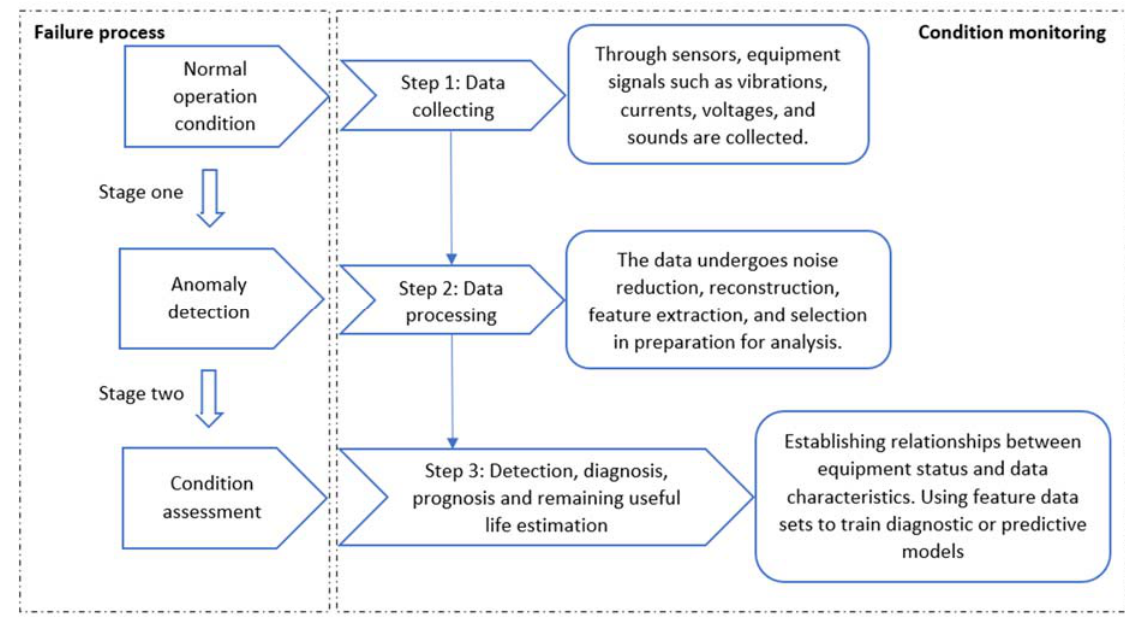
Figure 1. Process of equipment failure and steps of condition monitoring.